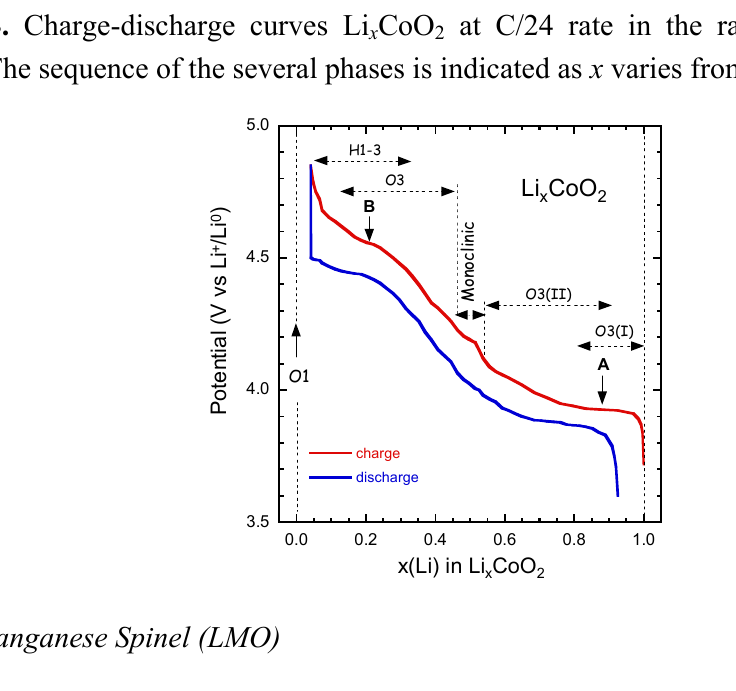
CoO at C/24 rate in the range 3.6–4.85 V vs. x 2